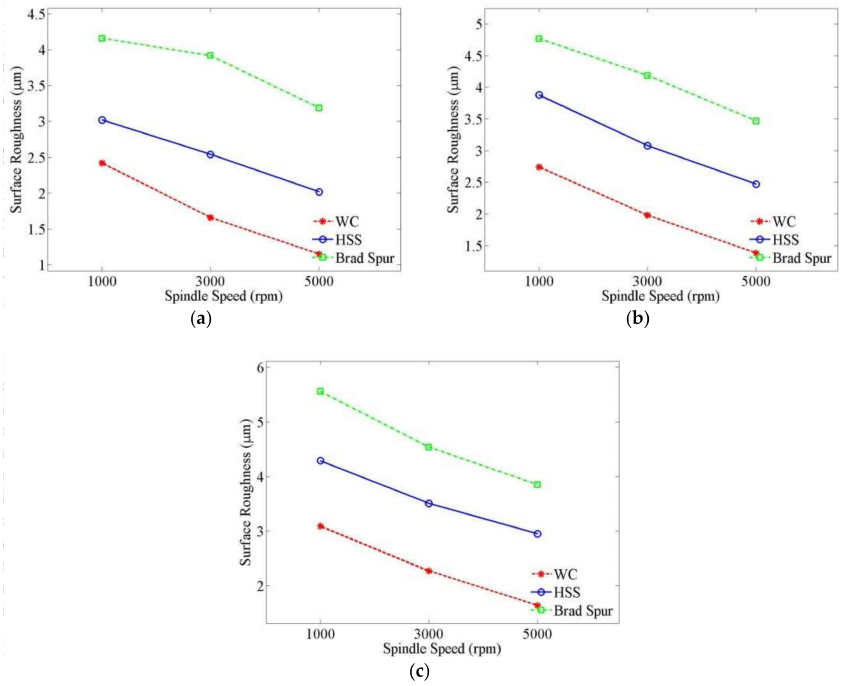
Figure 8. Variation of drilling parameters on surface roughness: ( a ) 0.05 mm/rev; ( b ) 0.10 mm/rev; ( c ) 0.15